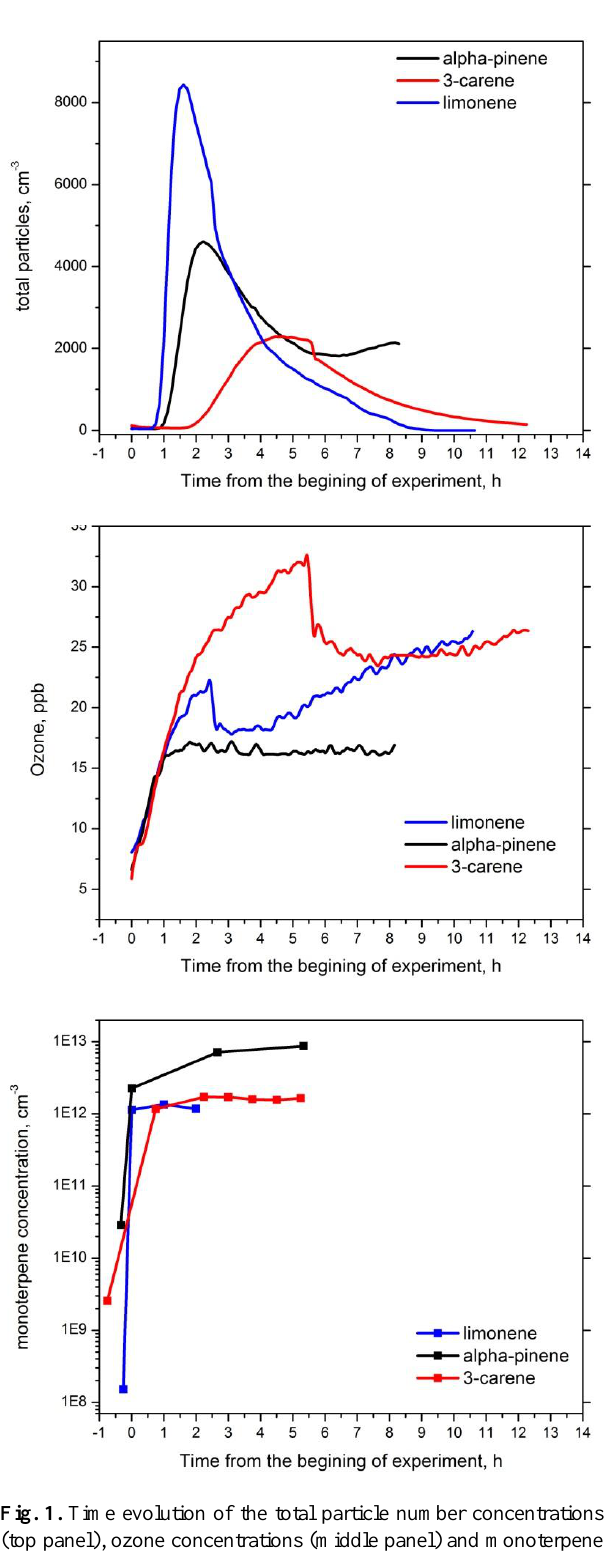
Fig. 1. Time evolution of the total particle number concentrations (top panel), ozone concentrations (middle panel) and monoterpene concentrations (bottom panel) during the selected experiments for limonene (blue line), 1 3 -carene (red line) and α -pinene (black